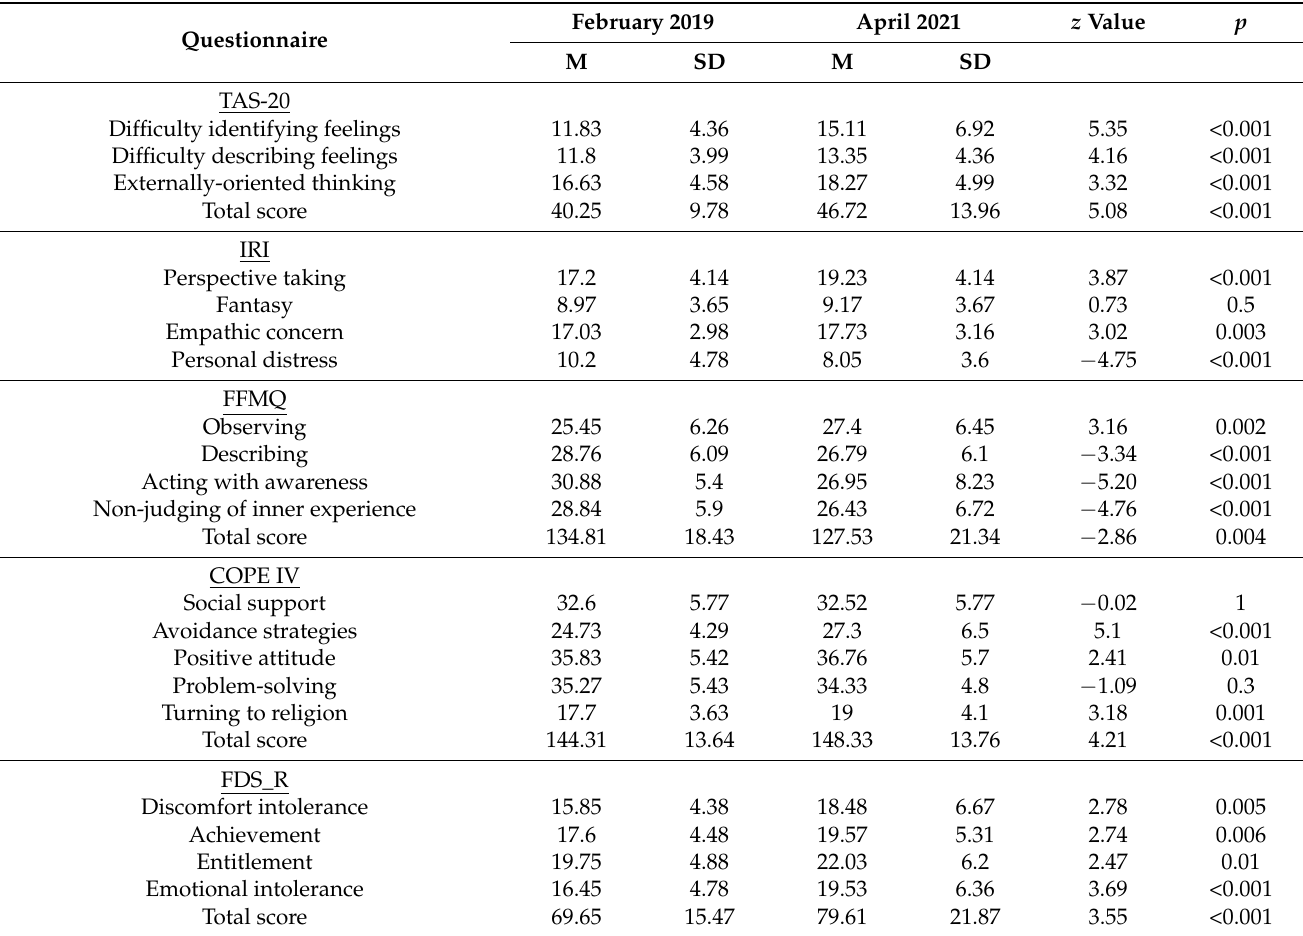
Table 5. Statistics on psychological